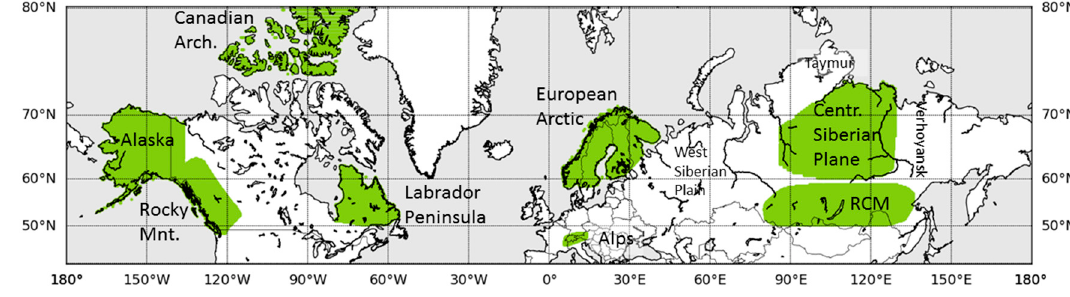
Figure 5. The areas listed in Table 2.